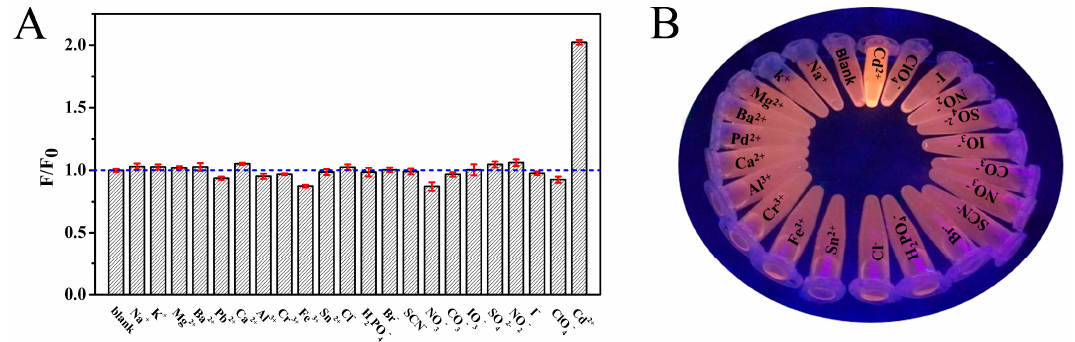
Figure 7. ( A ) Selective experiments of Au NCs for other competitive metal ions and anions; ( B ) Photographs of Au NCs under UV light after being incubated with various ions. ( B ) Photographs of Au NCs under UV light after being incubated with various